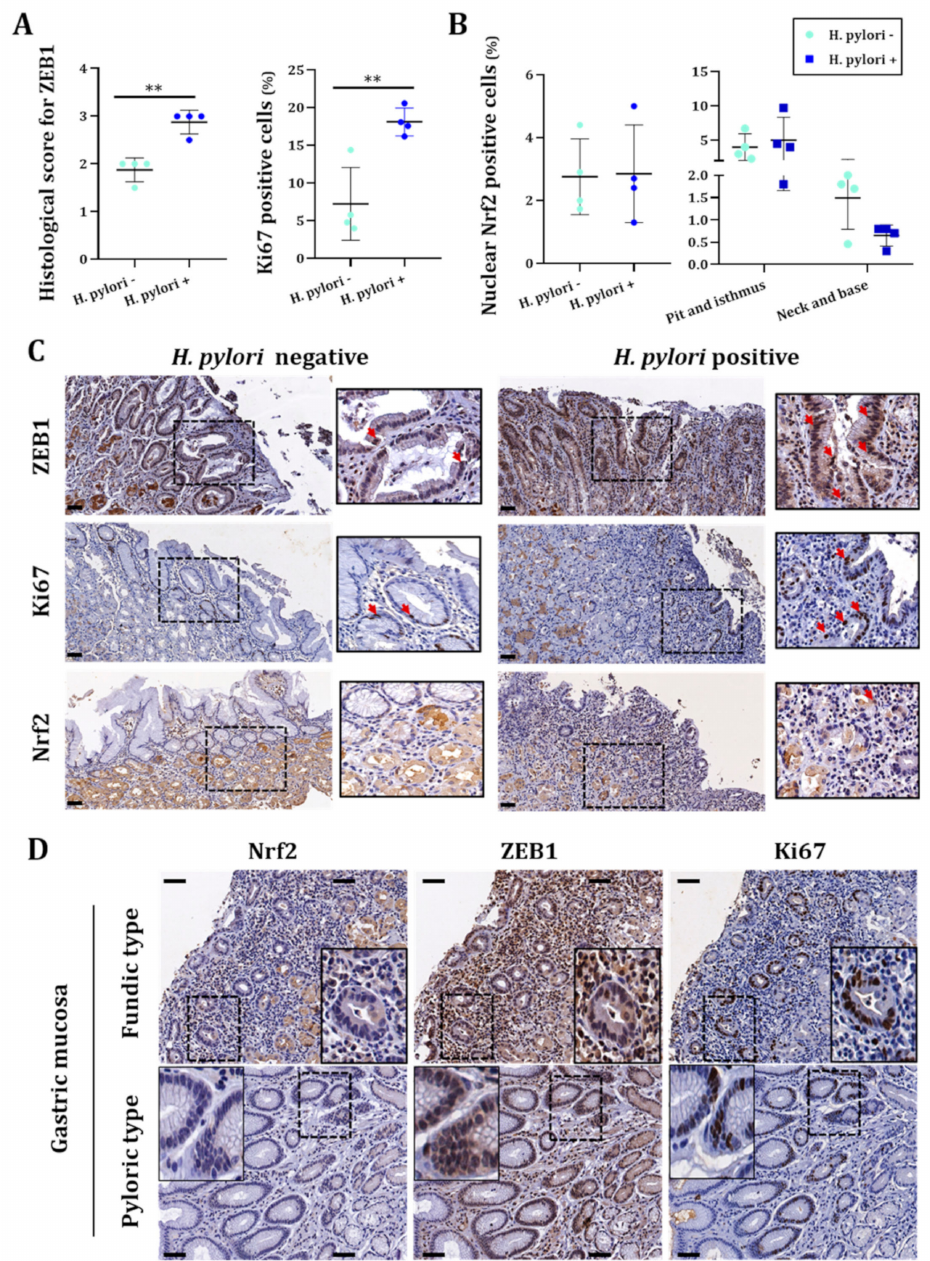
Figure 6. H. pylori infection tends to decrease Nrf2 expression in the bottom of gastric glands and is inversely correlated with the presence of ZEB1. ( A ) Evaluation of ZEB1 (histological score) and Ki67 (percentage of positive cells) in H. pylori negative or positive tissues by immunohistochemistry. Statistics were performed with a t -test. All p -value < 0.05 were considered significant. ** < 0.01. ( B ) Evaluation of Nrf2 (percentage of positive cells) in H. pylori negative or positive tissues by immunohistochemistry in the entire gland (left) or by separating the top (pit and isthmus) and the bottom (neck and base) of gastric glands (right). ( C ) Representative pictures of immunohistochemistry for ZEB1, Ki67 and Nrf2 expression in H. pylori negative or positive human gastric tissue samples. Red arrows denote immunopositivity. Scale bar: 50 µ m. ( D ) Qualitative analysis of consecutive serial sections for Nrf2, Ki67 and ZEB1 expression in the gastric mucosa (fundic and antro-pyloric areas) of H. pylori -infected patients. Scale bar: 50 µ